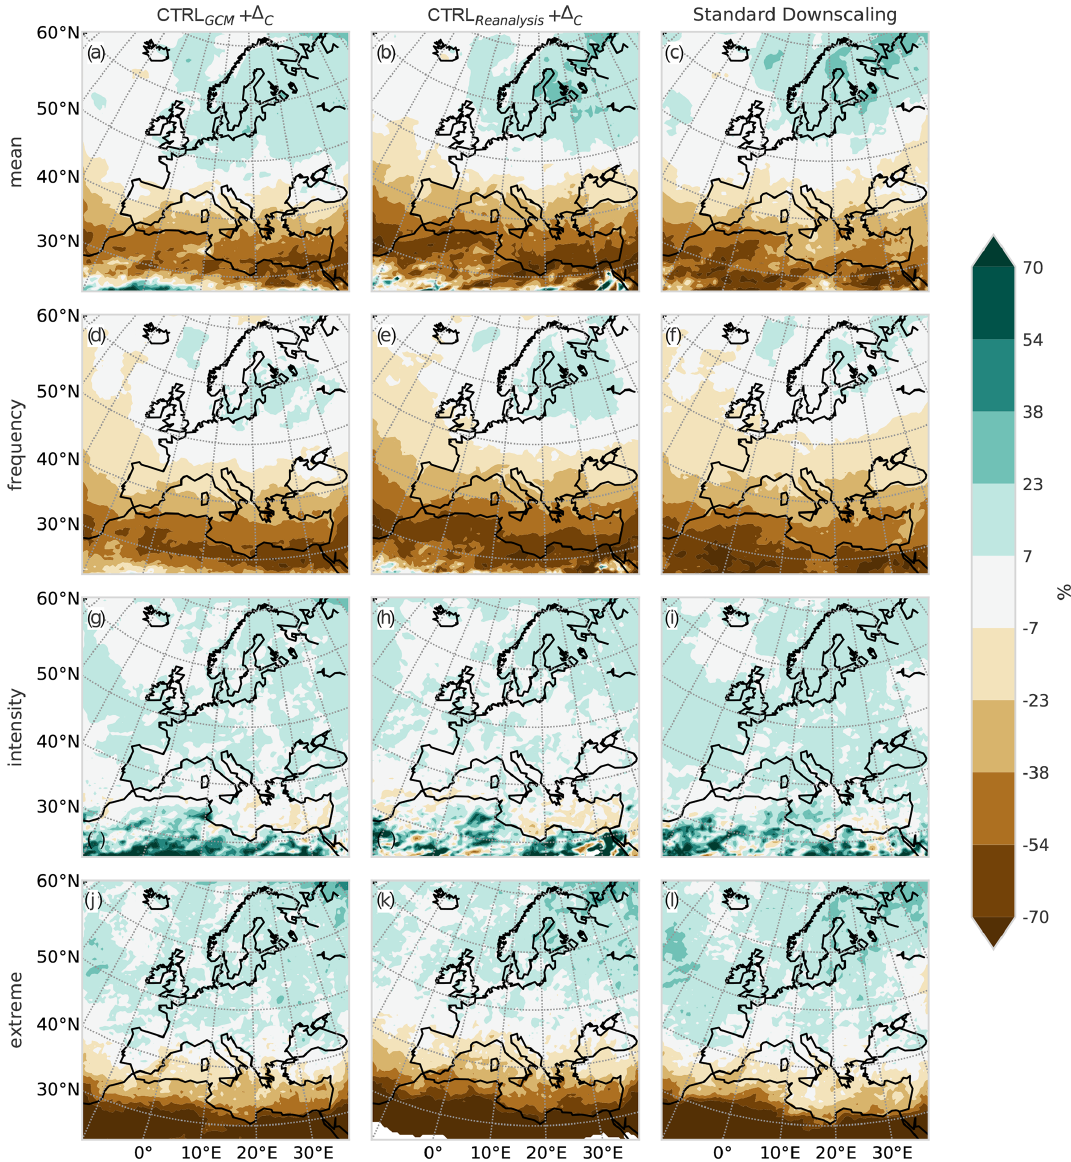
Figure 8. Similar to Fig. 7 but for annual mean changes in (a–c) mean precipitation, (d–f) precipitation frequency (days with precipitation ≥ 1mm), (g–i) precipitation intensity (precipitation amount on days with ≥ 1mm), and (j–l) extreme precipitation (99th percentile of all days), for three climate change projections. The first column (a, d, g, j) shows a GCM-driven CTRL simulation modified using the PGW approach. The second column (b, e, h, k) shows an ERA-Interim-driven CTRL simulation modified using the PGW approach. The third column (c, f, i, l) shows the standard GCM-driven transient climate simulation. Details on the models used are in Table